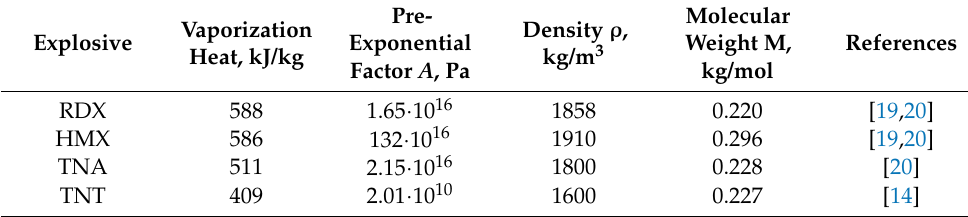
Table 1. Physicochemical properties of the explosives used.